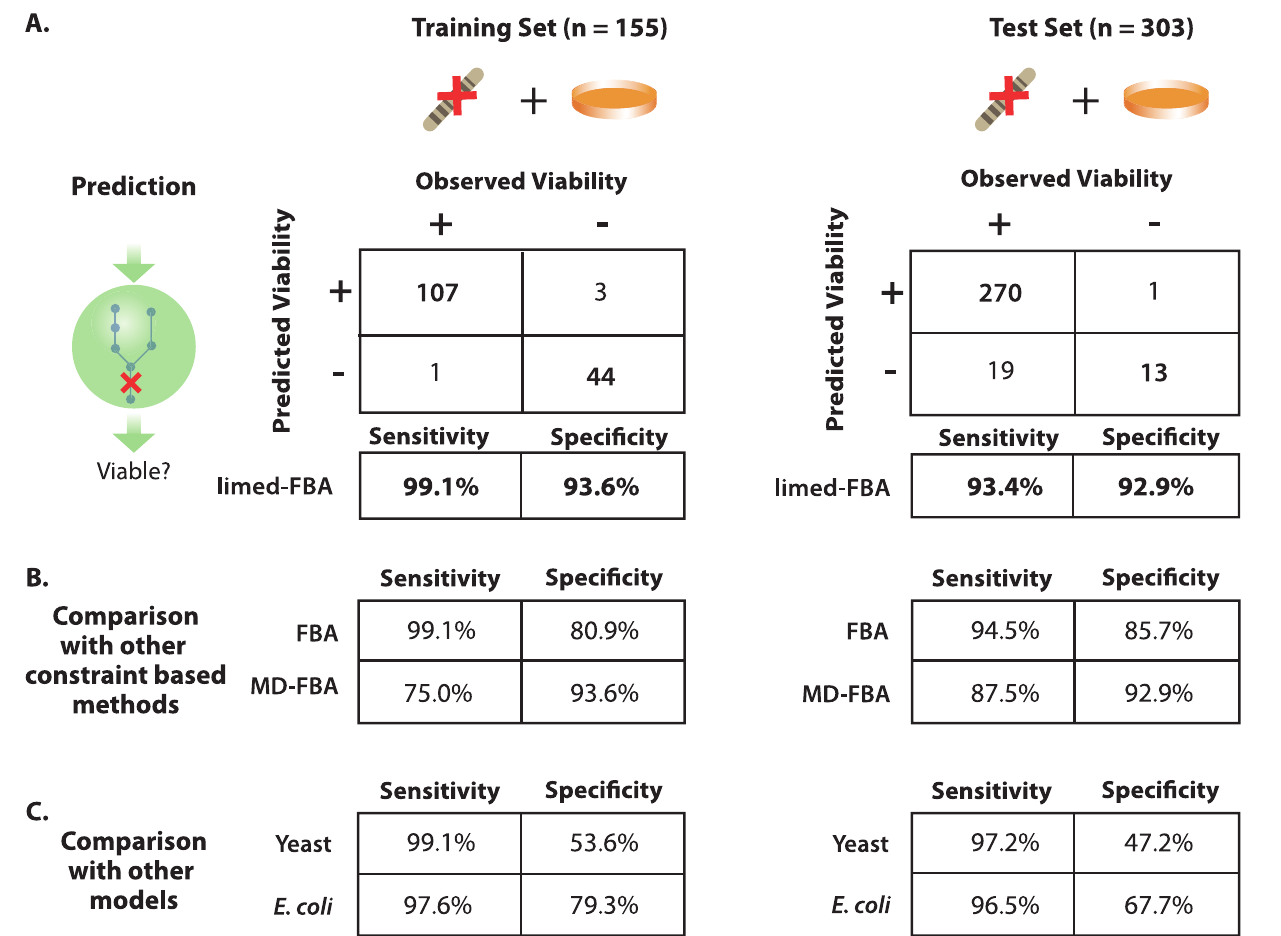
Figure 4. Minimal media gene essentiality predictions. We curated a collection of mutant viability observations on minimal media and separated the collection into a training set, where knowledge of the viability phenotype was used to improve the model; and a test set, where the viability phenotype was hidden from the model. (A) Training and test set mutant viability observations were used to measure the sensitivity and specificity of the limed-FBA gene knockout viability predictions. While some inconsistencies were due to model error, several were resolved in the model’s favor, as discussed in the text. (B) Using the same model, training and test sets, limed-FBA outperforms FBA and MD-FBA. (C) For comparison, we display the mutant viability prediction accuracies of previously published FBA models for S. cerevisiae and E. coli . Prediction accuracies of experimentally observed viability phenotypes that were used to optimize the model are displayed on the left panel [41,42]. Prediction accuracies of viability phenotypes that were not explicitly used to construct the model are displayed on the right panel